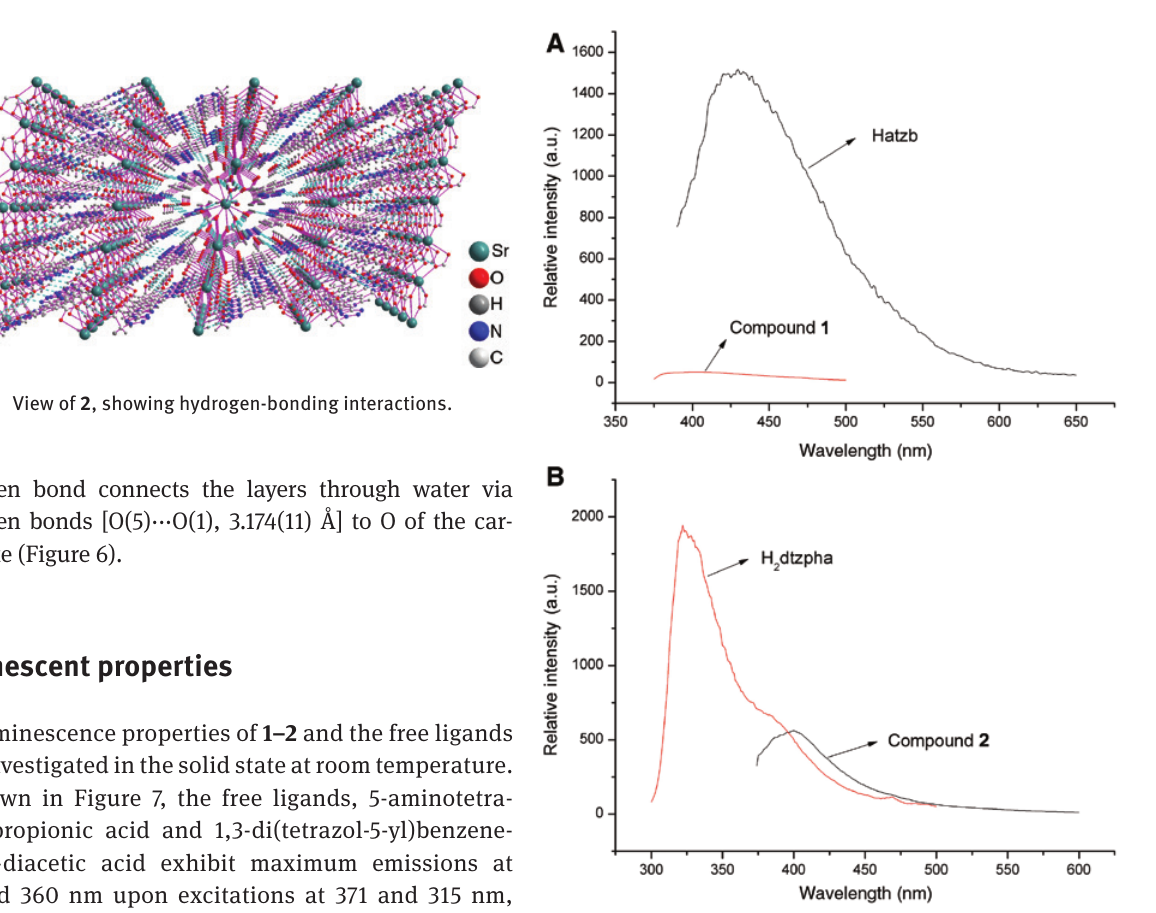
= 371 nm, for 1 λ = 357 nm). ex ex = 315 nm, ex